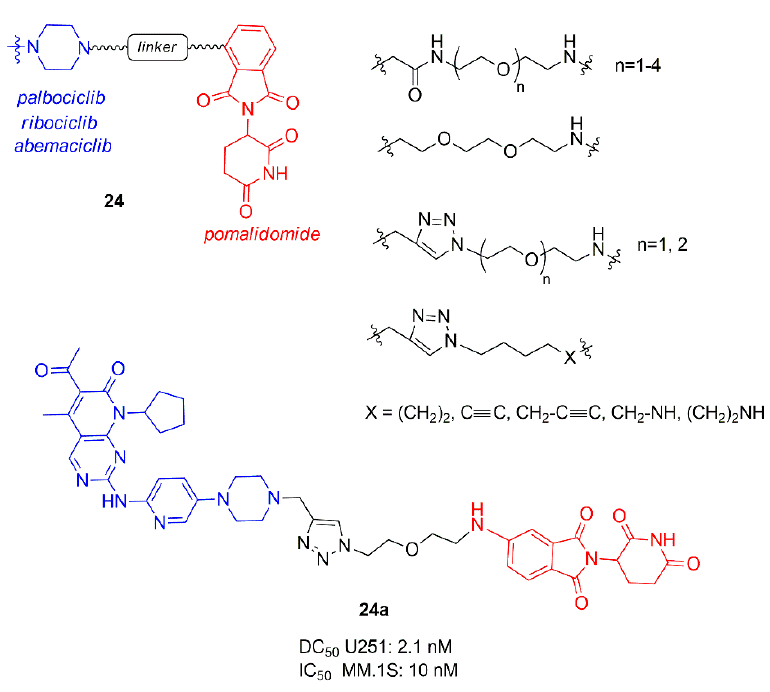
multiple myeloma MM.1S (IC 50 10 nM).